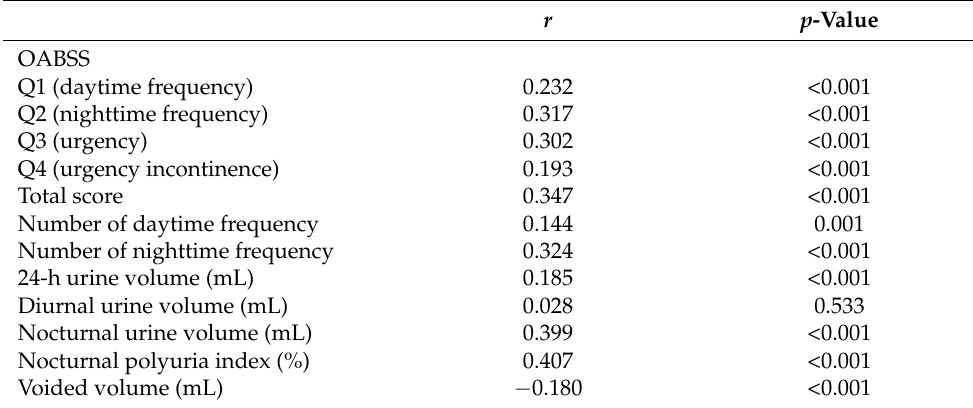
Table 3. Relationship between urinary calcium excretion volume and the severity of OABSS.